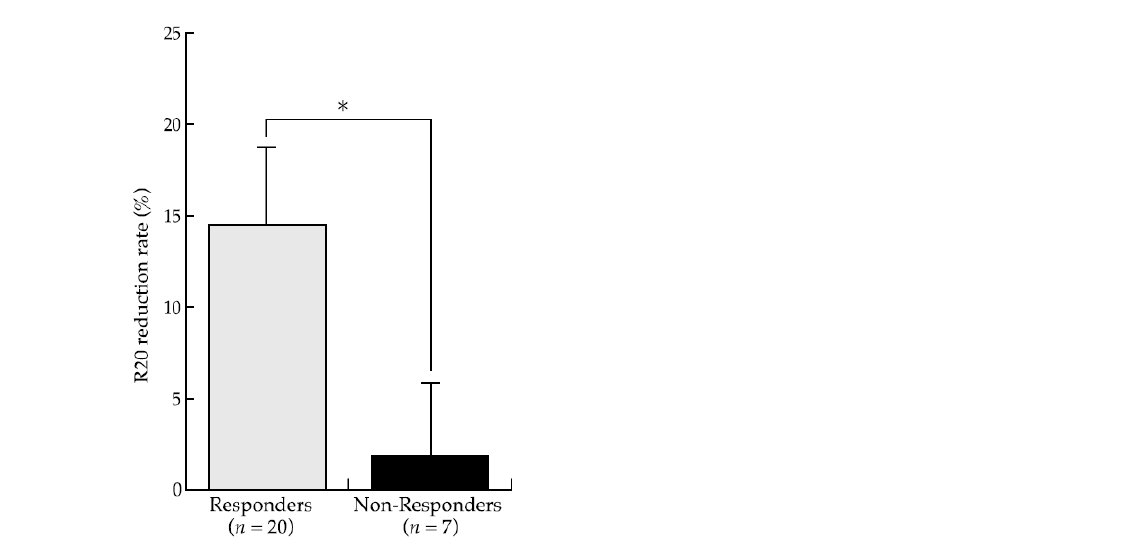
Figure 4. Comparison of responders and non-responders in terms of R20 improvement rates (* p < 0.05).